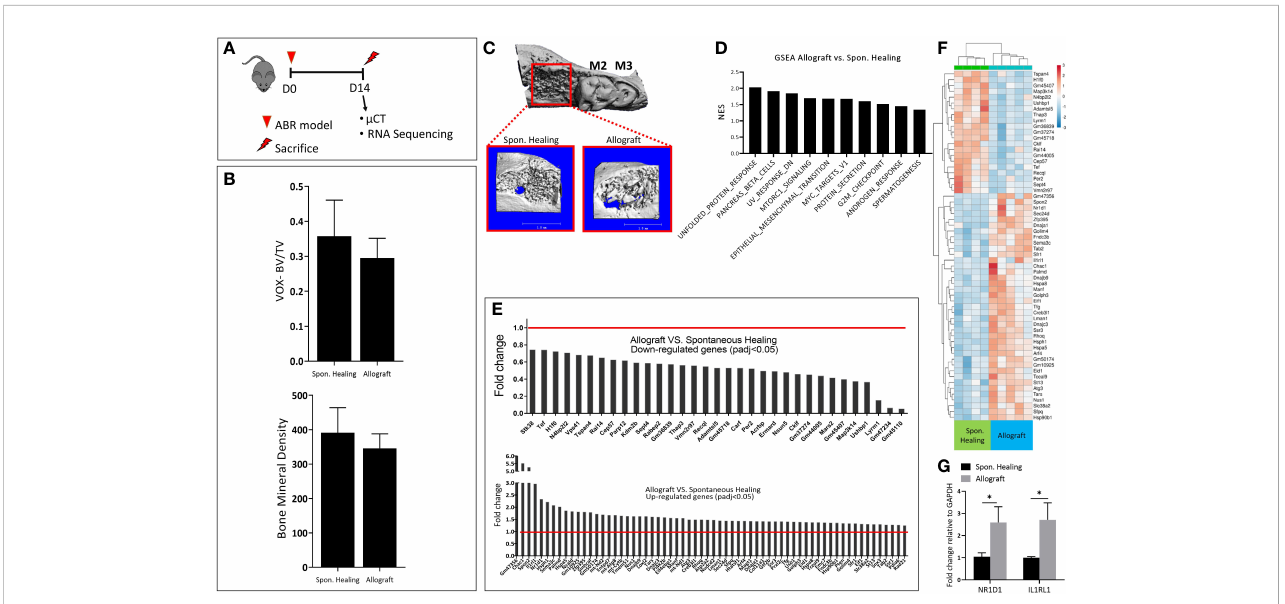
FIGURE 1 Bone healing two weeks following alveolar bone regeneration with Allograft vs. Spontan. Healing. (A) Experimental timeline: 8 weeks old male mice (C57BL =7/group) were divided into two groups; the control group of a tooth extraction without allograft implantation (Spon. Healing), an experimental group with allograft implantation, were sacri fi ced for radiographic and mRNA sequencing analysis 2 weeks post-procedure. (B) Numerical µCT evaluation of alveolar socket: bone volume/total volume (BV/TV) and Bone Mineral Density. (C) µCT 3- dimensional analysis of the regenerated alveolar bone (marked in red square), with magni fi cation. (D) Upregulated GSEA pathways in allograft treatment. (E) The highest differentially down\ up-regulated genes. (F) Heatmap showing the highest 60 Differentially expressed genes (DEGs) (G) mRNA validation for genes of interest (NR1D1,